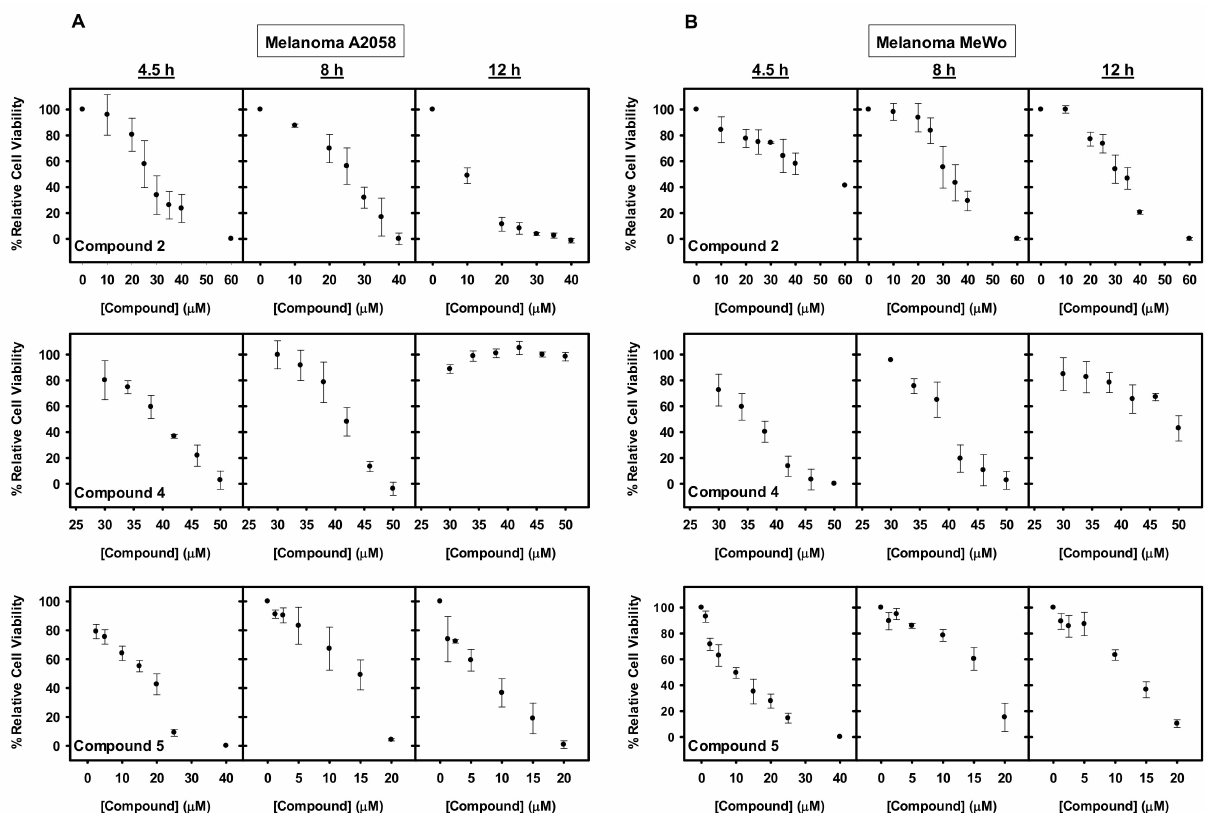
Figure 4. Cytotoxic effect of the studied compounds on A2058 and MeWo cells. ( A – B ) Dose and time-dependent effect of compounds 2 , 4 , and 5 on the viability of ( A ) A2058 and ( B ) MeWo cells. Cells were treated with the concentrations indicated during 4.5, 8, and 12 h. Following treatment either XTT or Presto Blue were added, and samples were measured in a spectrophotometer after 4 or 2 h, respectively. The values are expressed as means ± SD obtained from three independent